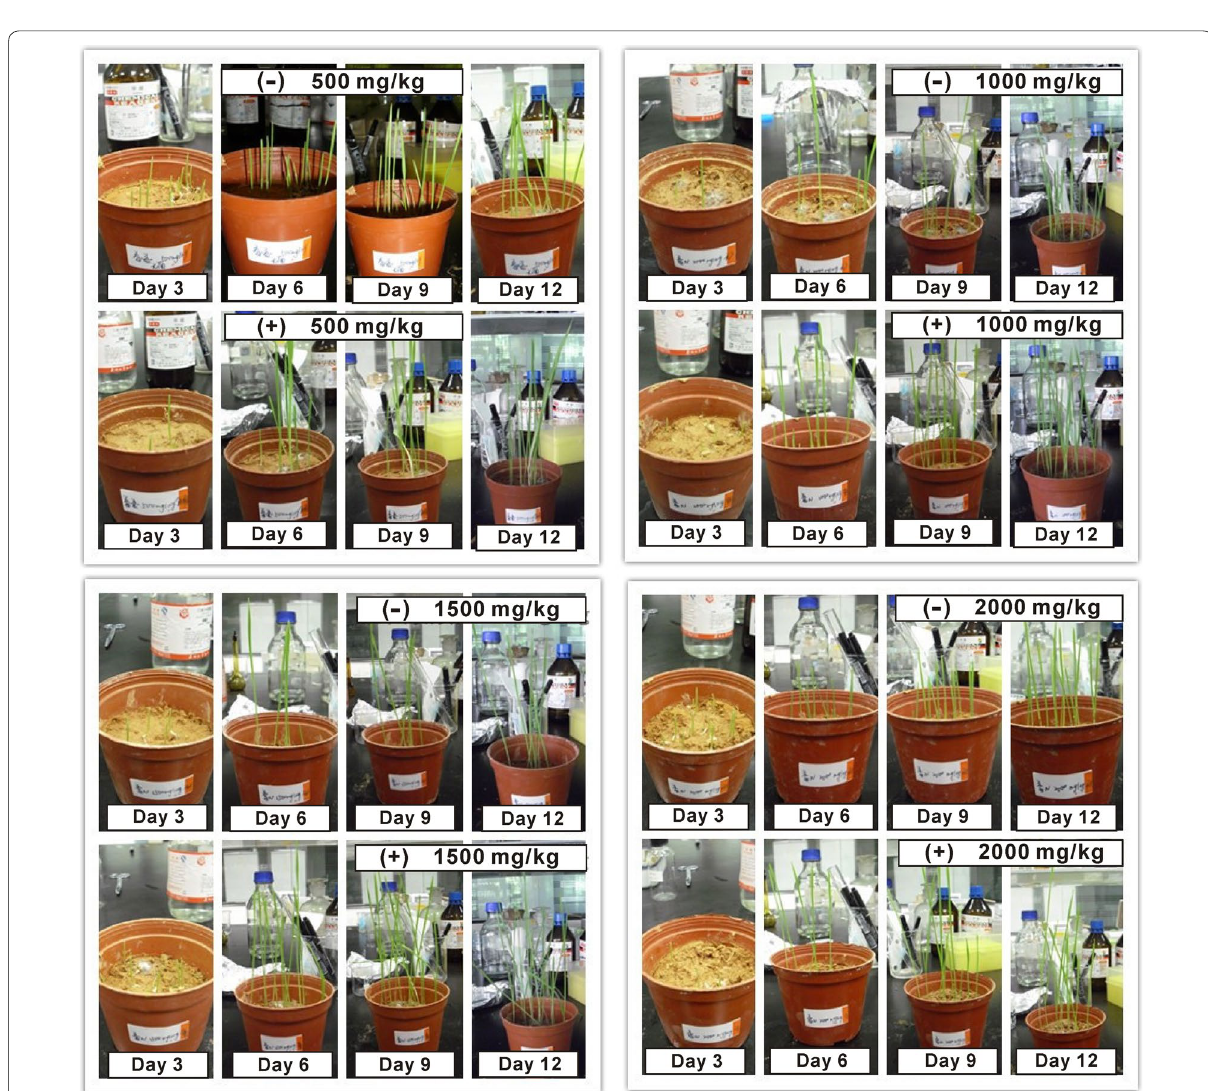
Fig. 6 The promotion effect of strain Gan‑35 on the growth of Nepeta cataria . Nepeta cataria was grown in the red soils containing NH 4 + ‑N at the concentrations of 500, 1000, 1500, and 2000 mg/kg, respectively. (